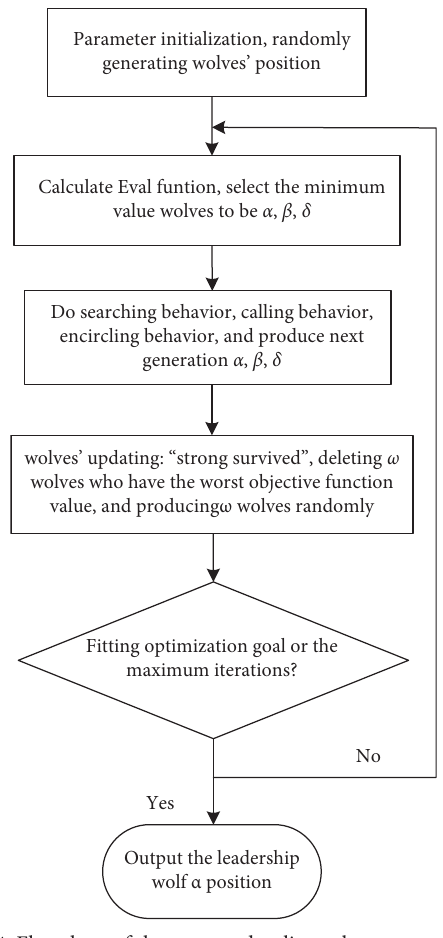
Figure 4: Flowchart of the proposed online robust control scheme optimized by the GWO